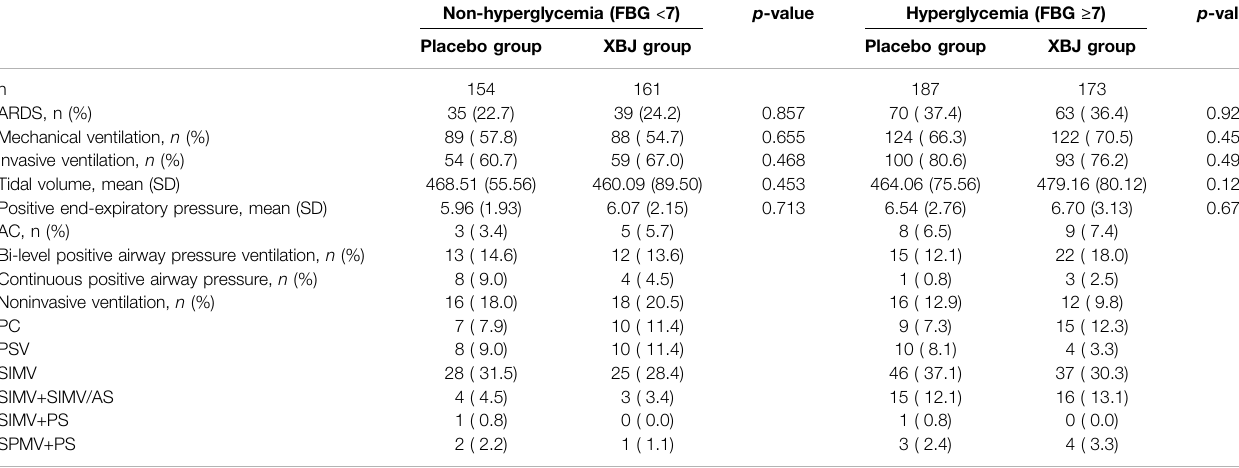
TABLE 4 | Rate of patients with ARDS and the baseline settings of mechanical ventilation in the FBG group